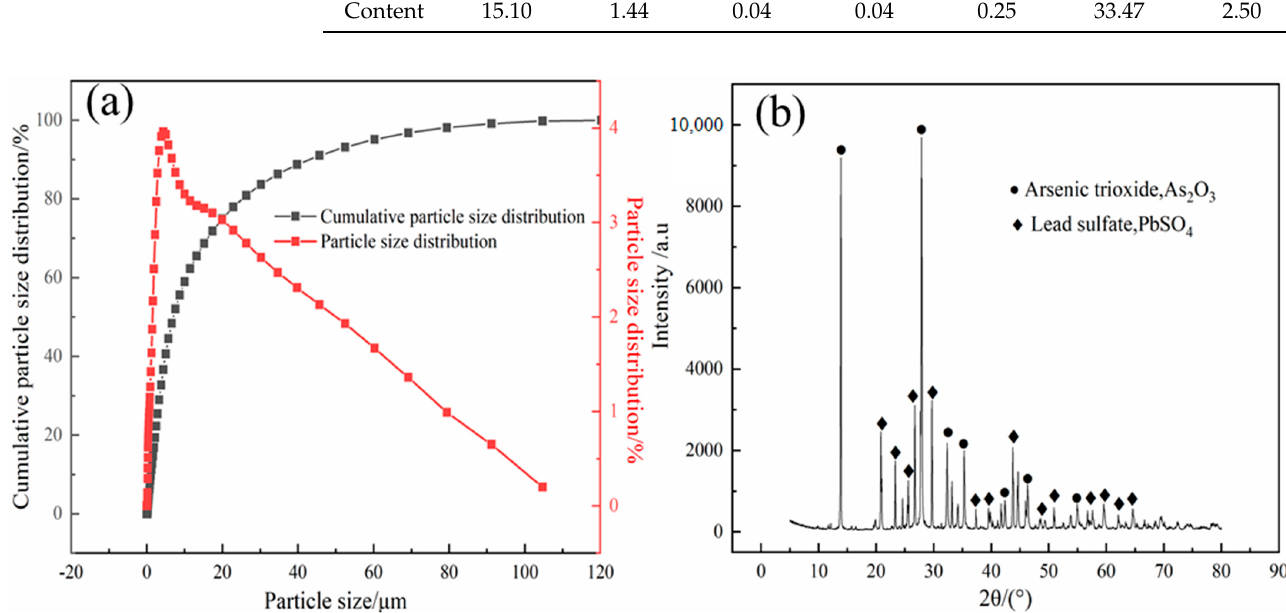
Figure 1. ( a ) Cumulative particle size distribution and particle size distribution of the lead slime; ( b ) XRD patterns of the lead slime. a.u: arbitrary